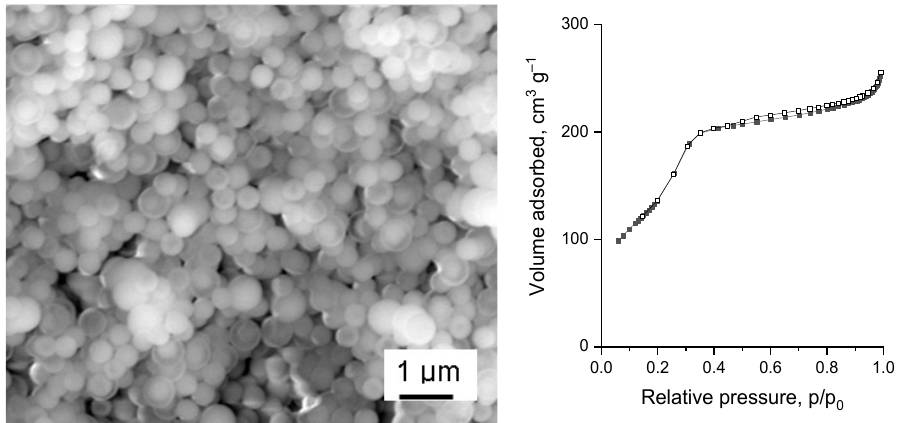
Figure 1. SEM image ( left ) and low temperature N 2 adsorption/desorption isotherm ( right ) of porous silica nanospheres (NS).